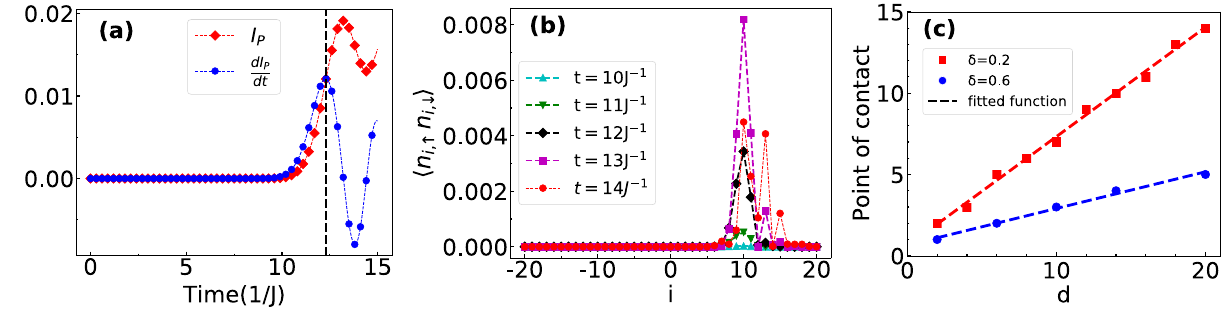
Figure 12. ( a ) I P and dI P dt are plotted with respect to time. Black dashed line represents the time at which dI P dt is † † 0.2 . ( b ) The point of contact is maximum. Here we consider the initial state | (cid:31) 0 � = a 14, ↓ | vac � and δ = − 14, ↑ a n i , ↑ n i , ↓ shown by plotting with respect to the site at different times. The time t = 12.28 J − 1 corresponds to the black dashed line of ( a ). ( c ) Point of contact of the two particle wave functions are plotted with different d of the † (cid:31) (cid:30) | vac � . The red squares and blue circles are the data for δ = 0.2 and 0.6 respectively. a † initial state | (cid:31) 0 � = a − d , ↑ d , ↓ The dashed lines are the fitted